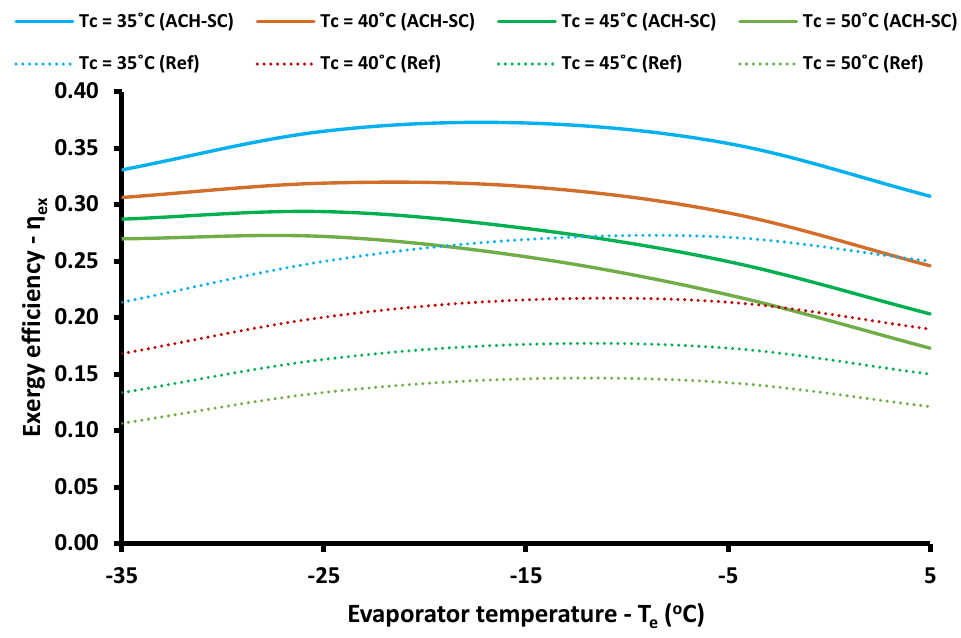
Figure 13. The exergy efficiency of the absorption chiller subcooling system compared to the reference case for all the examined optimized scenarios. Appl. Sci. 2018 , 8 , x FOR PEER REVIEW 17 of 28